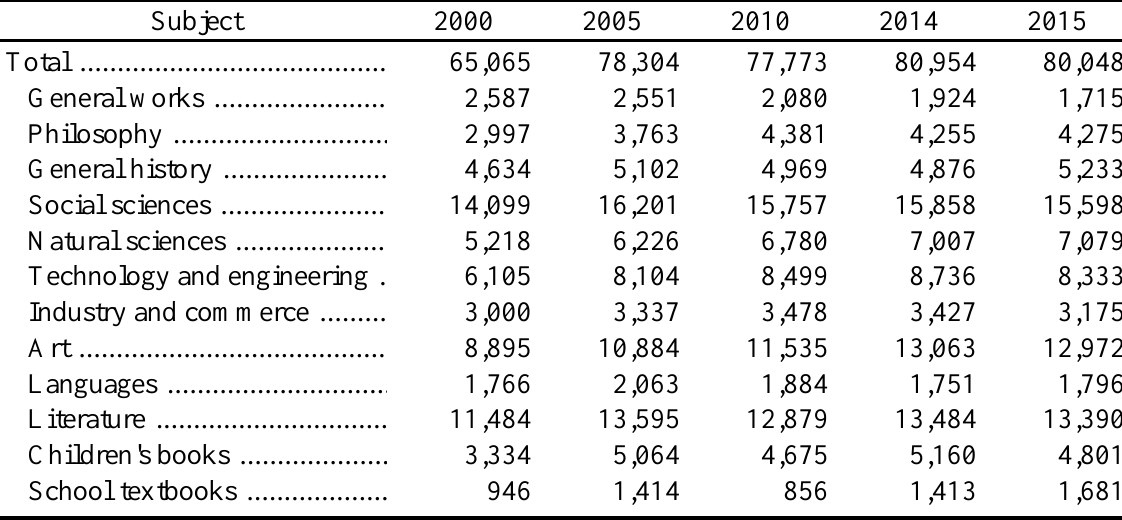
Newspaper Circulation by Country (2015)